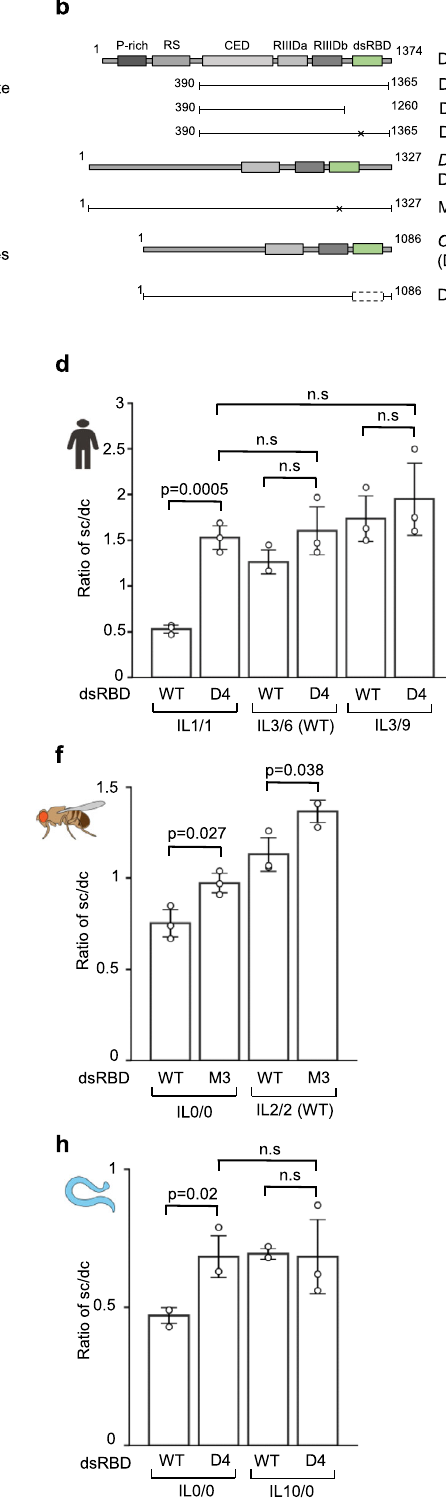
The ILs cause the single cleavage of animal DROSHAs by disrupting the dsRBD and lower stem interaction . DROSHA uses the dsRBD to recognize and bind to the lower stem of pri- miRNAs 11,12,14 (Fig. 4a). In addition, the ILs located in the lower stem diminish the 3p-strand cleavage ability of DROSHA. Therefore, any distortion in the lower stem (due to the ILs) might abolish its interaction with the dsRBD, and thus block the 3p-strand cleavage.